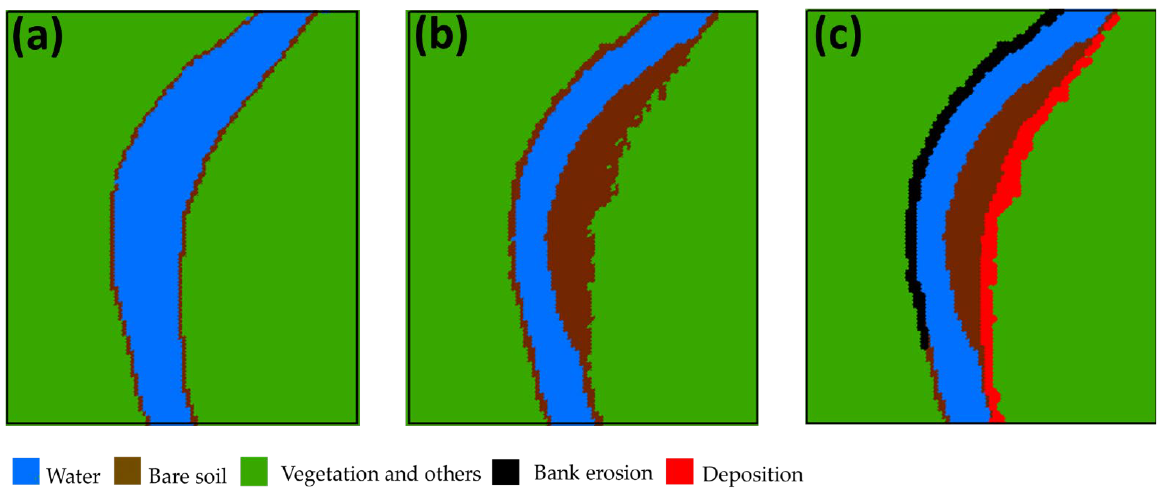
Figure 6. Results of the land cover analysis in the wet season ( a ) and dry season ( b ). In ( c ), the black color represents bank erosion, indicating the land cover changing from vegetation and others to water. The red color denotes deposition, which means the land cover changes from water to vege- tation and others.